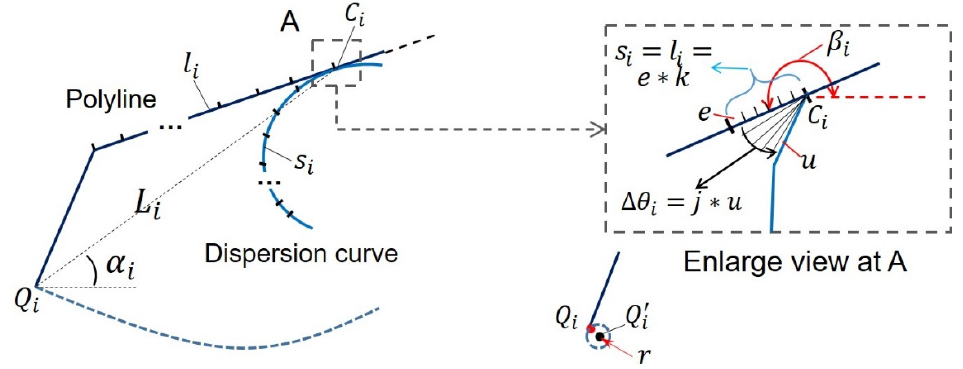
Figure 4. Discrete optimization process of the involute.